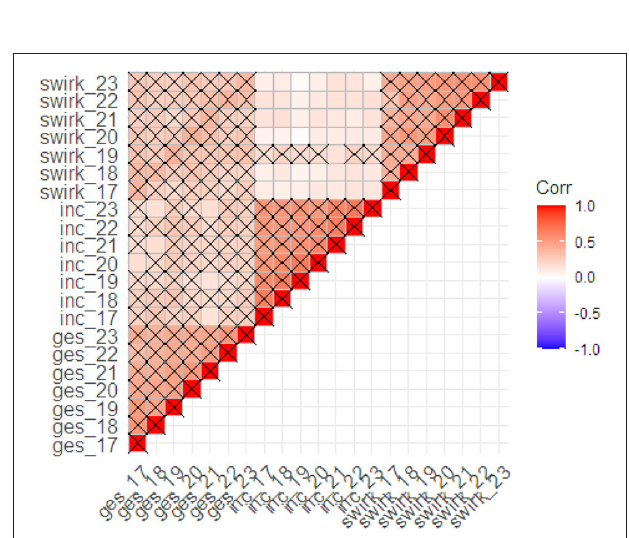
FIGURE 3 | Observed correlations between the three dependent measures across all measurement points. ges, subjective health status; inc, satisfaction with income; swirk, locus of control; 17–23, survey wave (corresponding years: 2003–2009). Crossed cells are significant at p < 0.001.